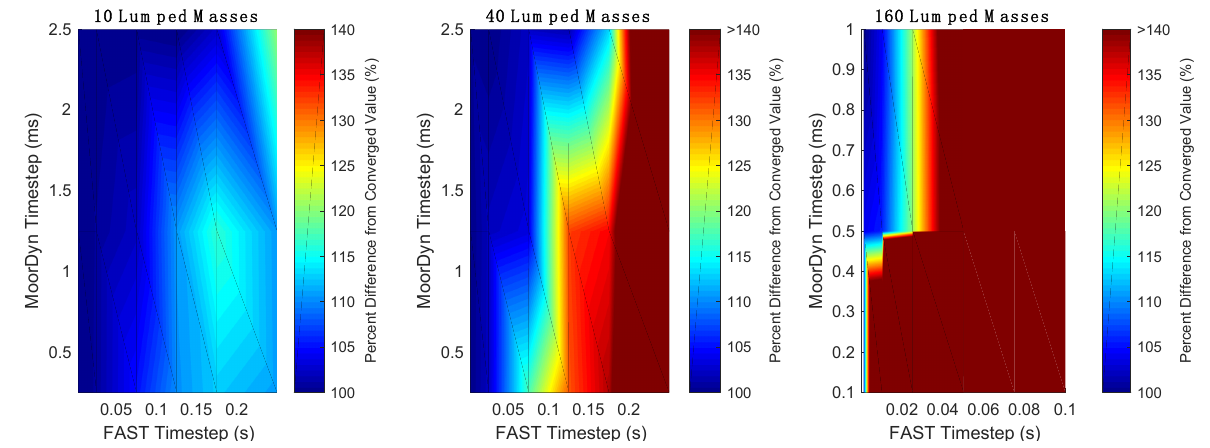
Figure 9. OpenFAST and MoorDyn Time Step Convergence Study.